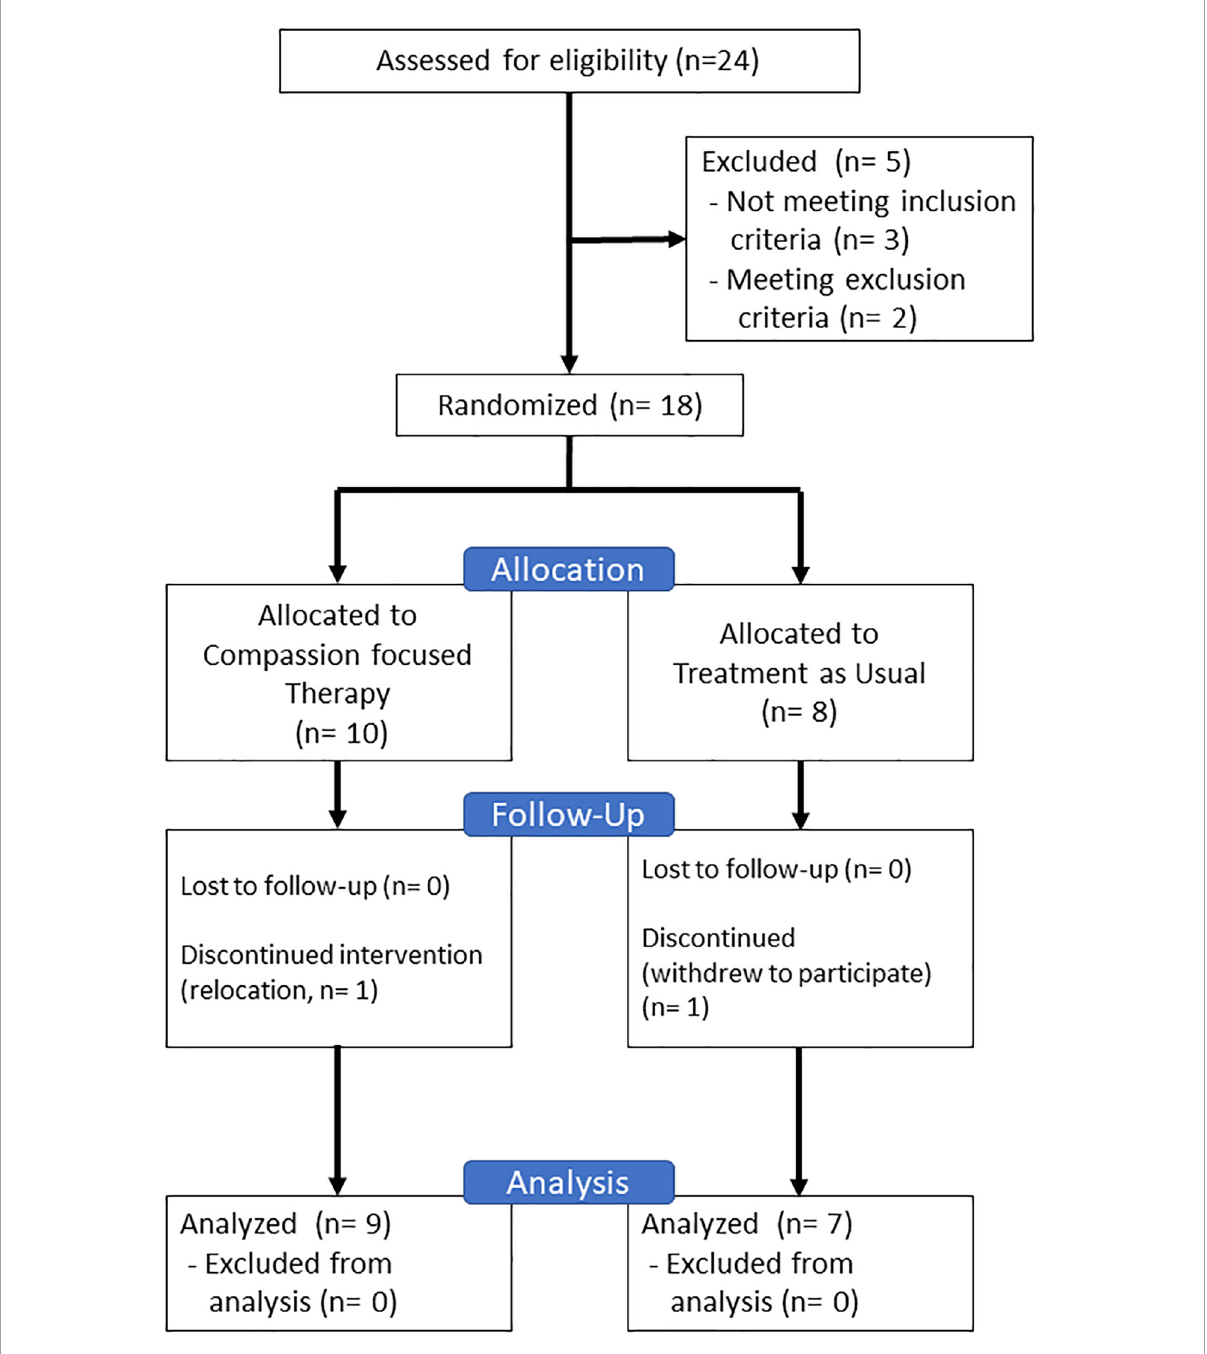
FIGURE1 CONSORT diagram in this